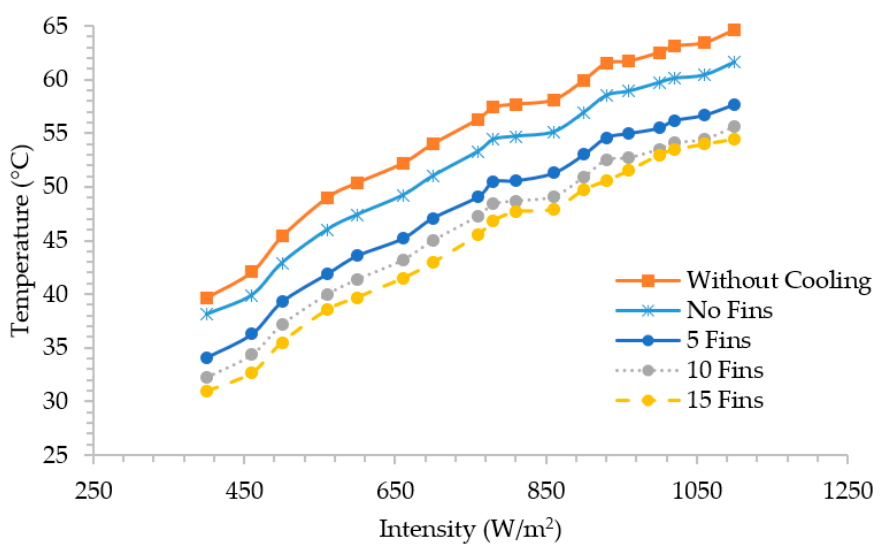
Figure 4. Relationship of solar radiation intensity to working temperature.